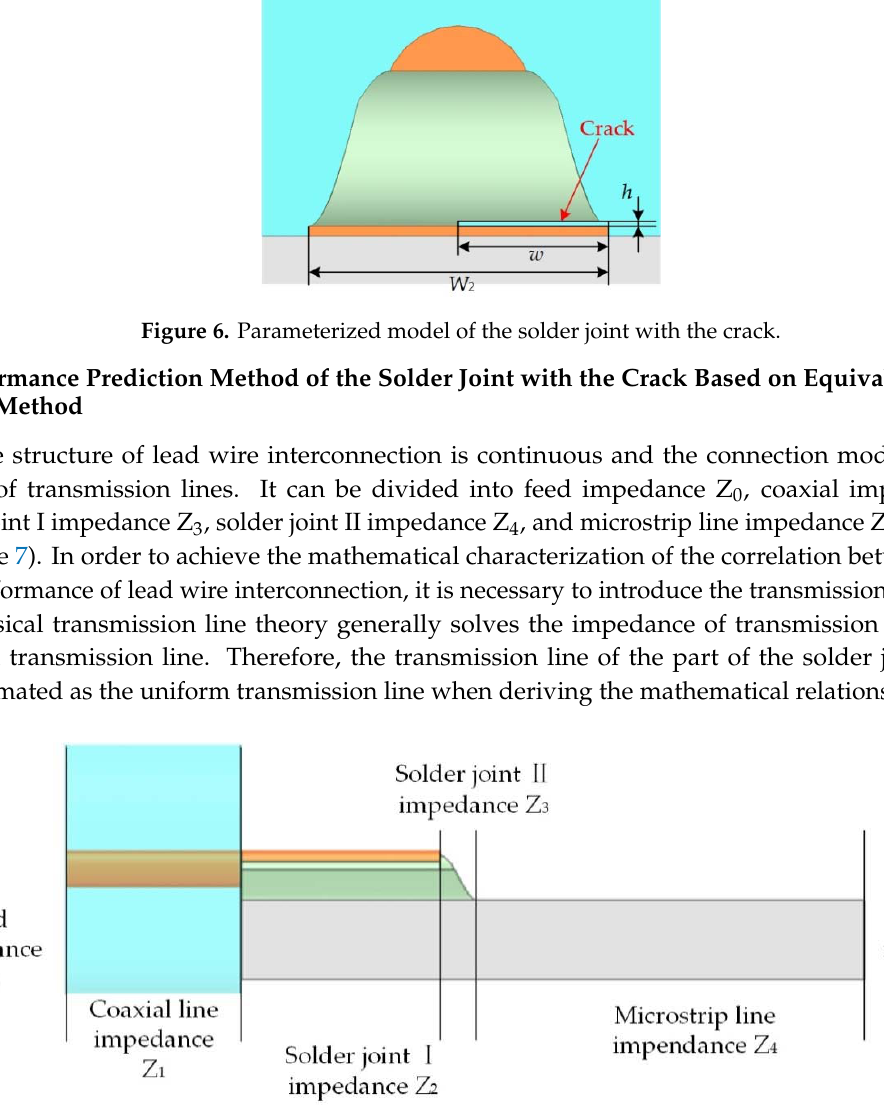
Figure 7. Structure decomposition diagram of lead wire interconnection.